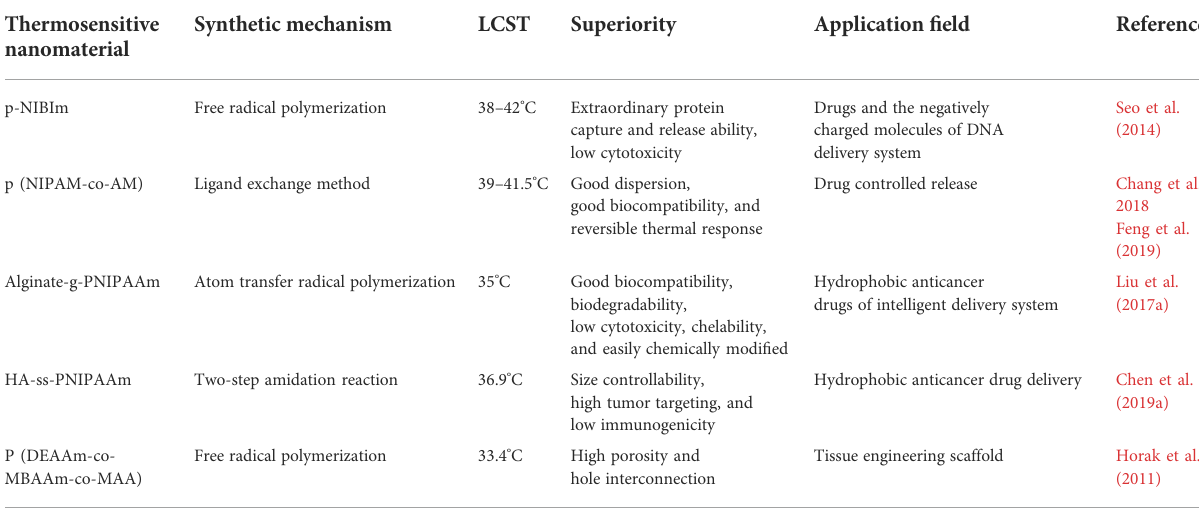
TABLE 2 List of thermosensitive nanomaterials based on